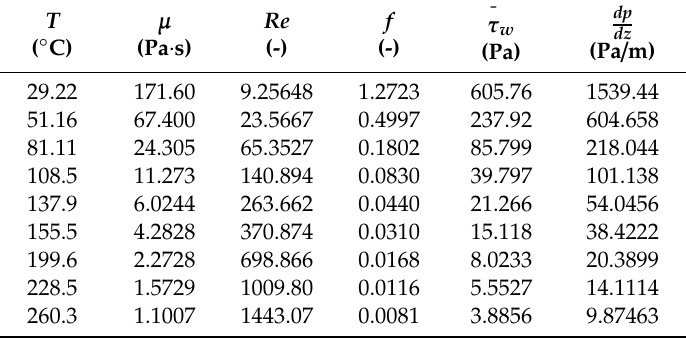
Table 10. Values of the fluid dynamic parameters obtained in the simulations with β = 0.06 and N = 16.